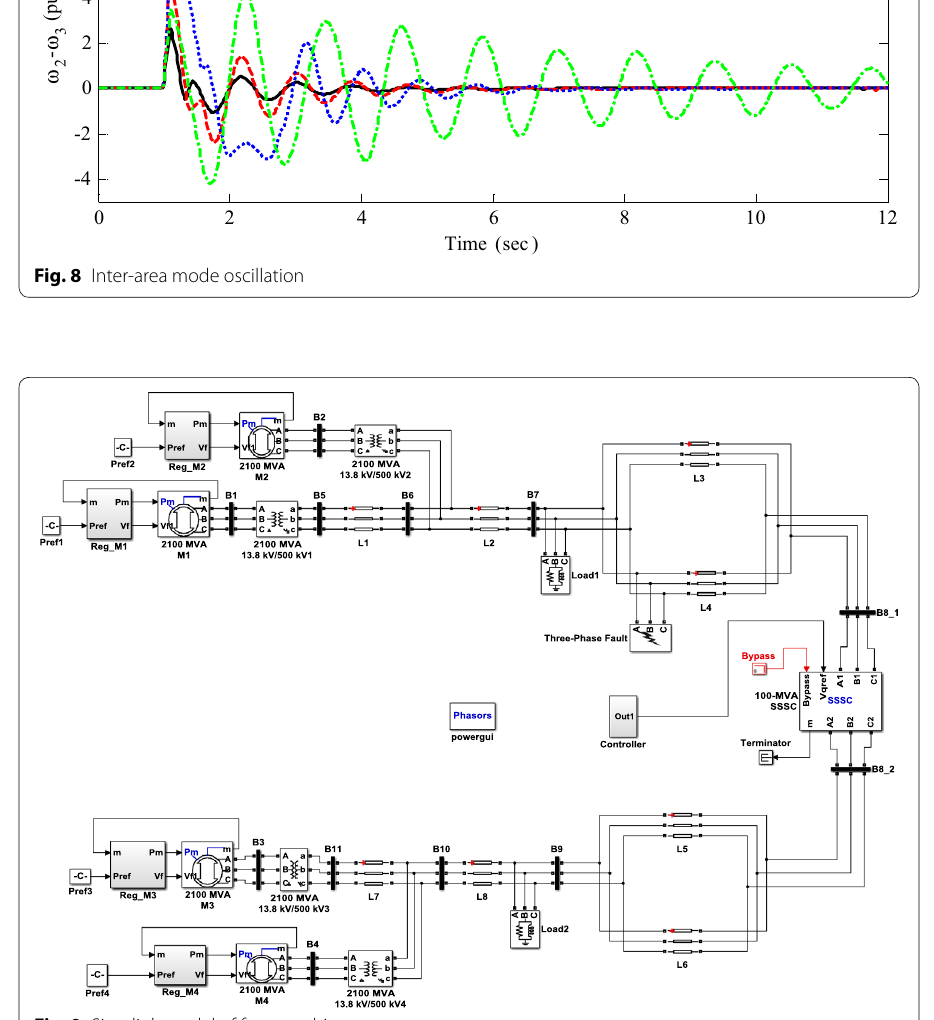
Fig. 9 Simulink model of four-machine